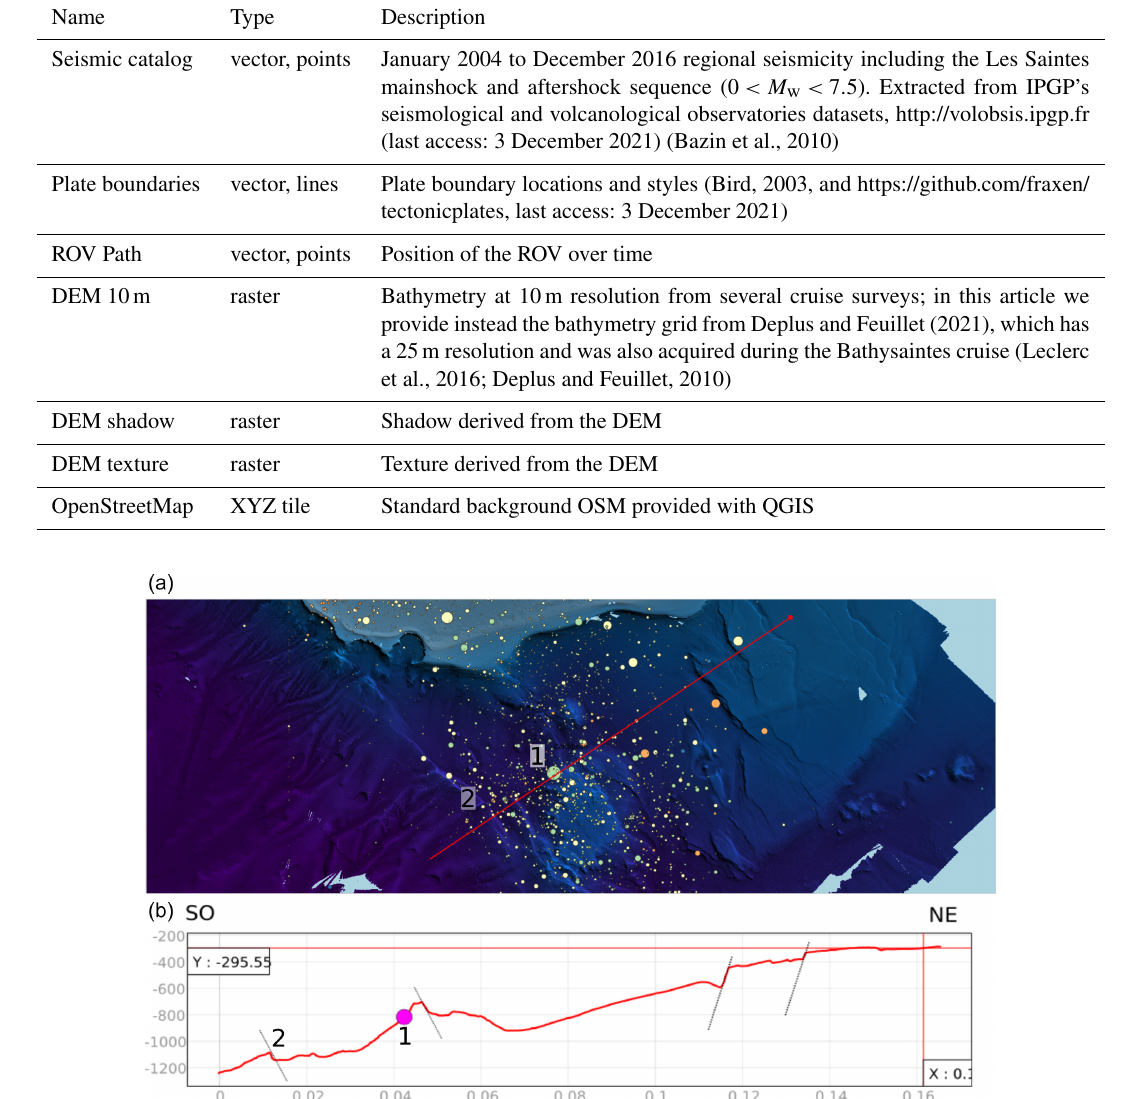
Table 1. Description of the layers imported in the QGIS project (see Supplement).